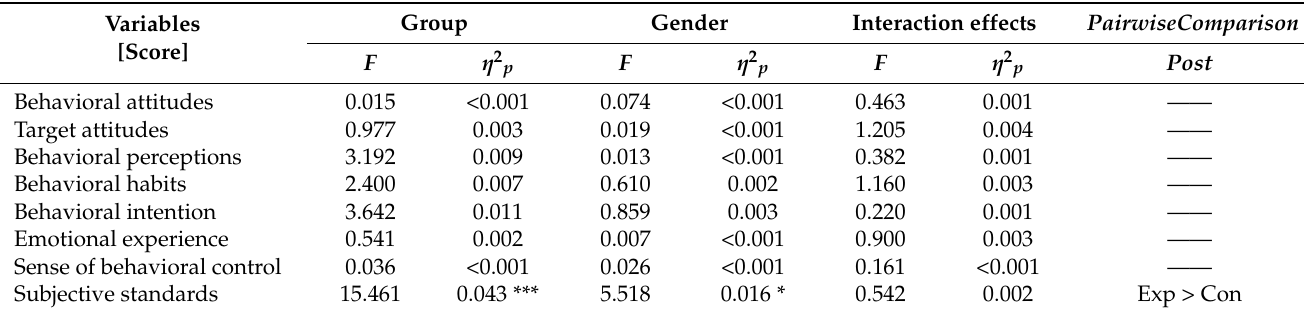
Table 8. Analysis of covariance of the exercise attitude test indexes between the experimental and control